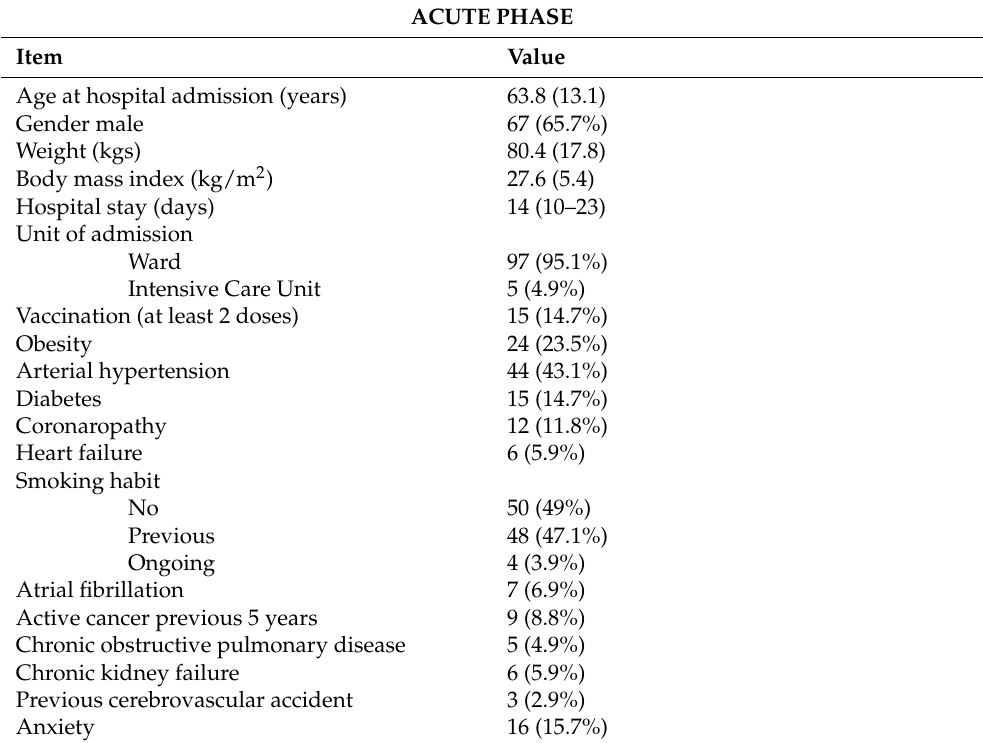
Table 1. Patient population (N = 102) details during the acute phase of the disease and at follow-up. ACUTE